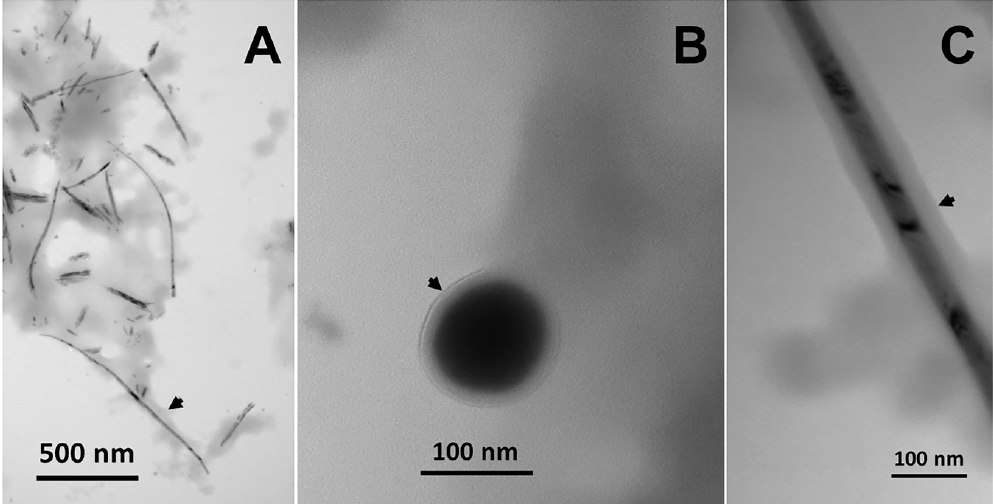
Figure 3. Biogenic nanomaterials in the form of tellurium nanorods (TeNRs) ( A ), selenium nanoparticles (SeNPs) ( B ), and selenium nanorods (SeNRs) ( C ) produced by the actinomycete Rhodococcus etherivorans BCP1 cells grown in liquid-rich medium amended with either potassium tellurite of sodium selenite as metal salt precursors. Arrowheads point toward the slight electron-dense organic coating featuring biogenically produced nanostructures.